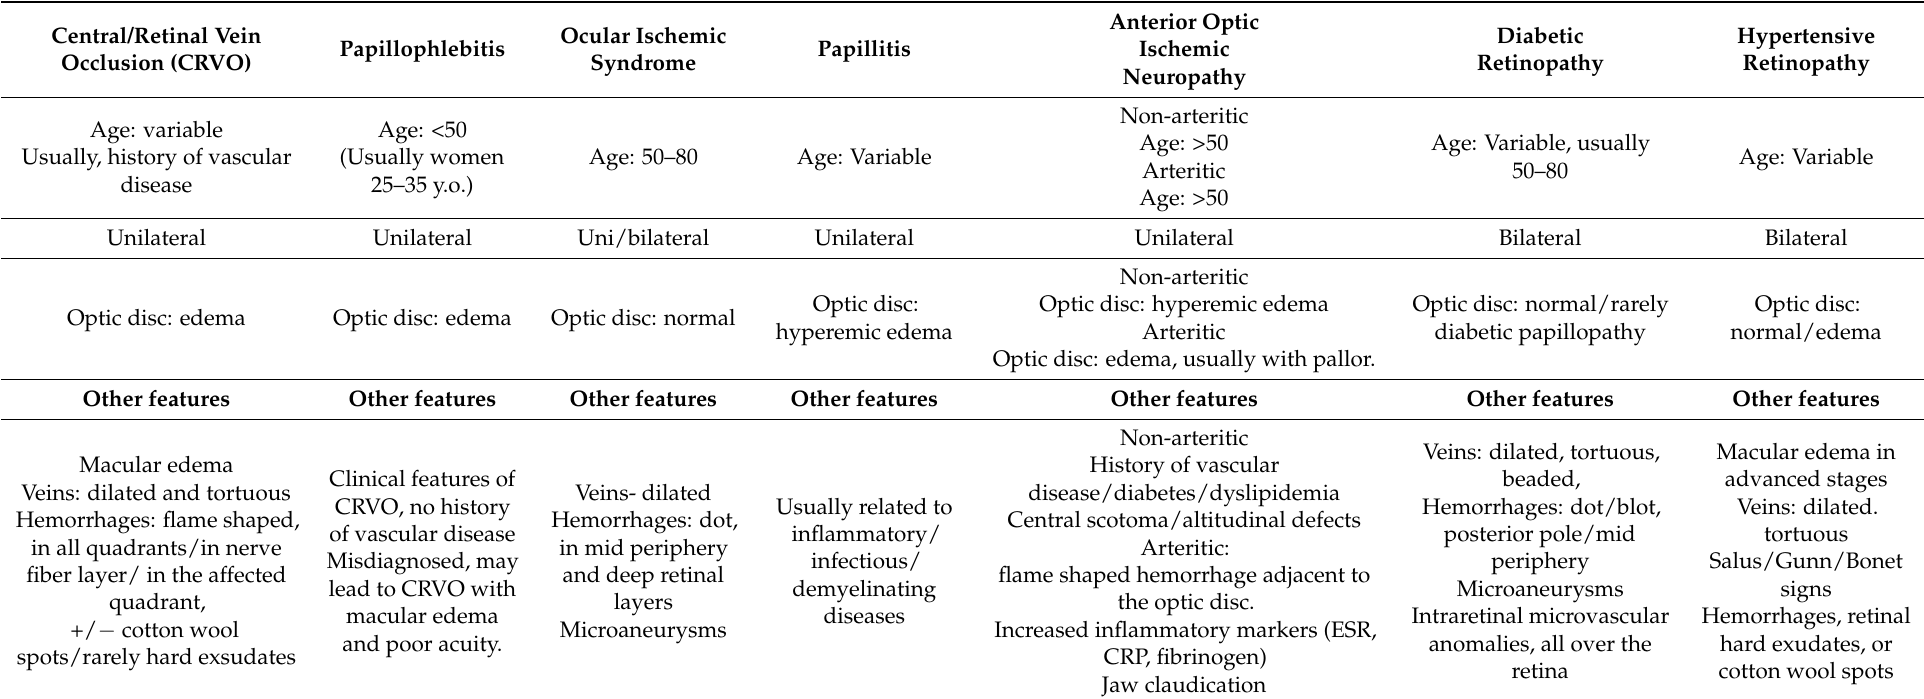
Table 1. The differential diagnosis of the